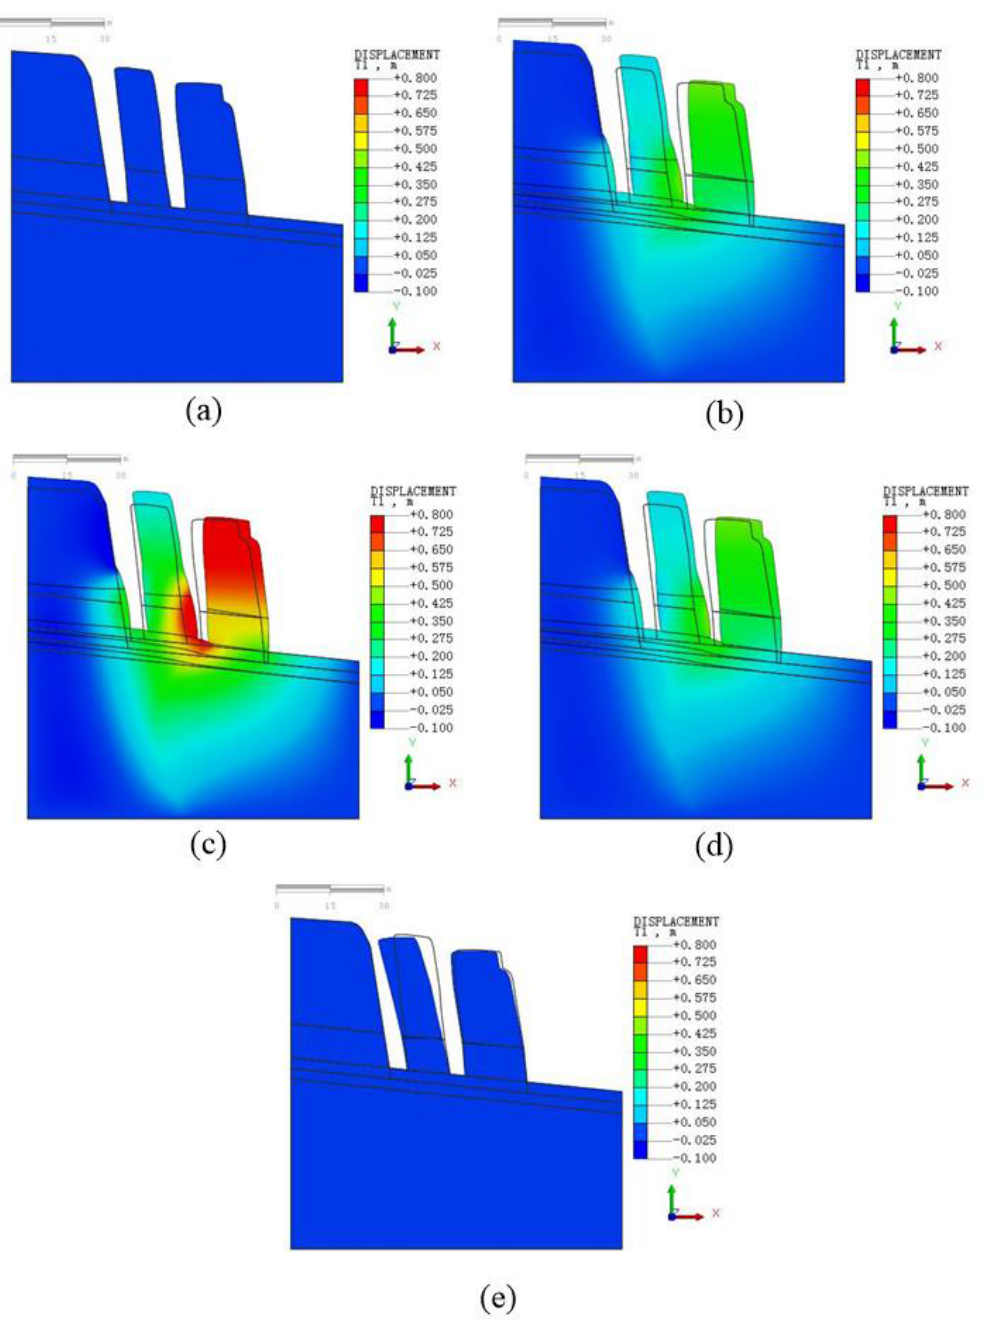
Figure 11. Example of finite-element simulation and numerical calculation: (a) the initial state (step 0), (b) tilt and slide, which occurs with an increase in accumulated water level (step 1), (c) bodies slide to the maximum state (step 2), (d) bodies tilt and slide when the accumulated water level decreases (step 3), (e) bodies tilt backward and stop creeping when the water level decreases to original values (step